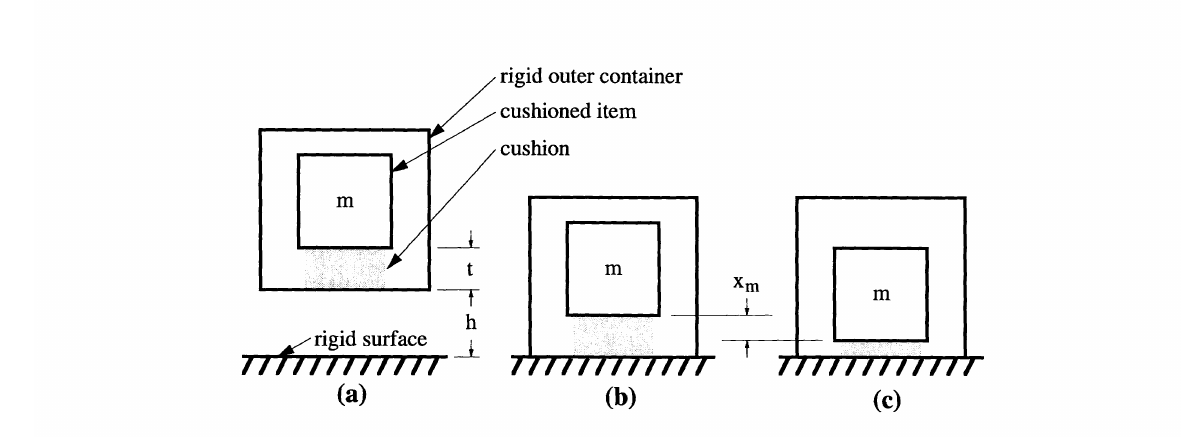
FIGURE 6 Basic cushioning problem: (a) at instant of release, (b) at instant of contact with the rigid surface, and (c) at time of maximum acceleration. Adapted from Mustin